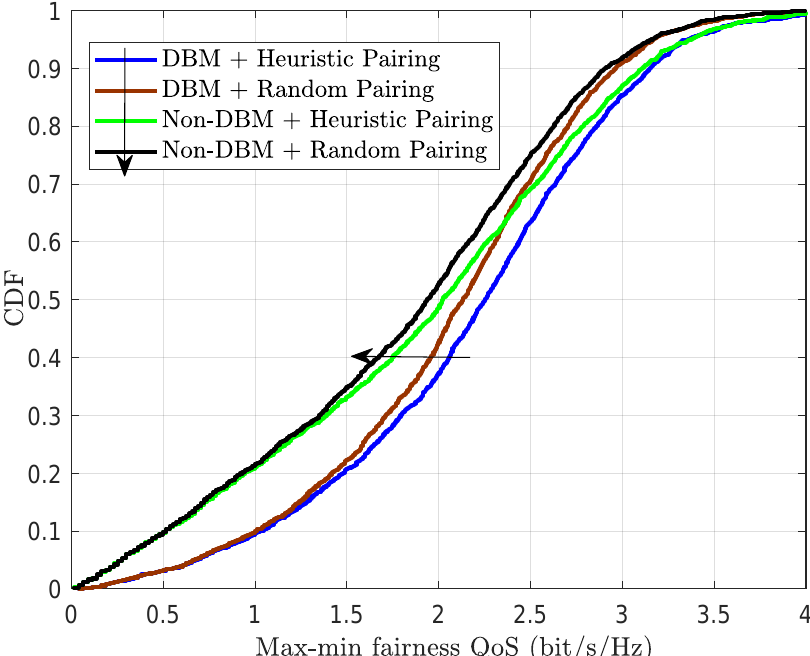
Figure 3. The cumulative distribution function of the max-min fairness QoS